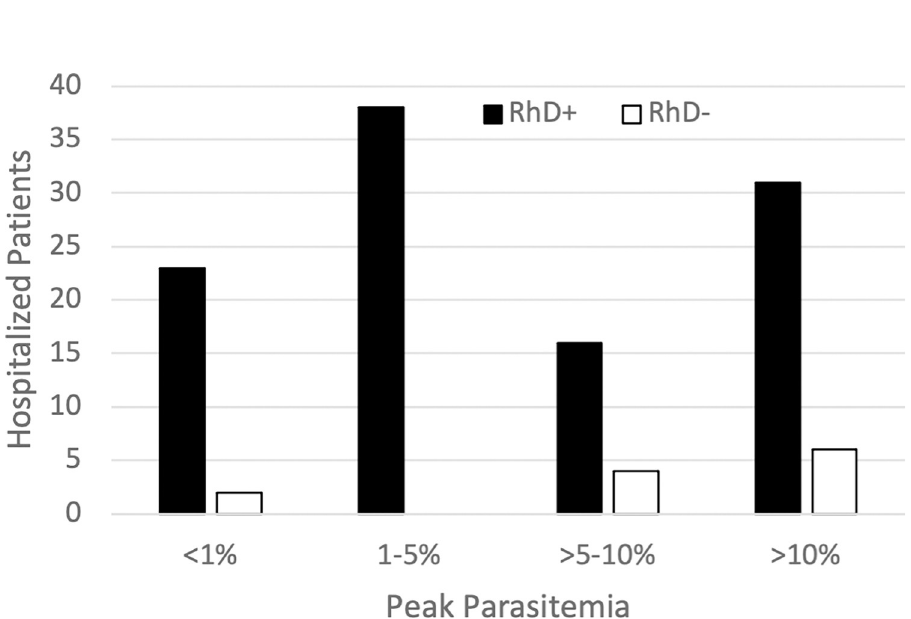
Fig 3. Peak parasitemia percentages in babesiosis patients at Yale New Haven Hospital by RhD blood type. The p- value for Fisher’s exact test was 0.017, indicating a significant association between peak parasitemia and RhD- blood type.